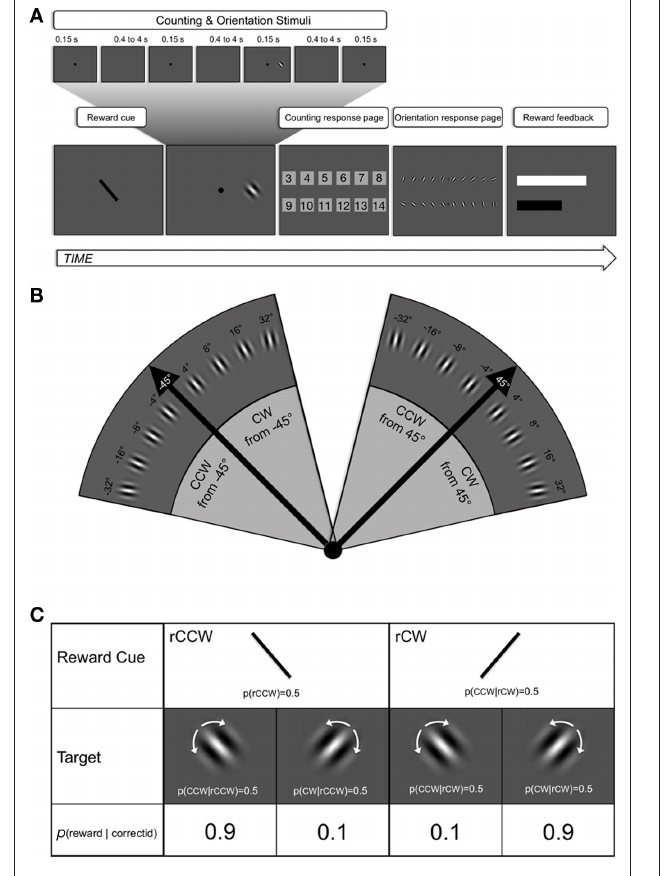
Figure 1 | Temporal structure of a trial (A), stimulus space (B), and reward patterns (C). (A) A trial began with a foveal line (subtending 3 ° of visual angle) displayed for 500 ms and tilted either 45 ° clockwise (CW) or counterclockwise (CCW) from vertical. Then the central attention loading task started. It consisted in a sequence of 3 to 14 flashes (100 ms, random) of a foveal disks with a random inter-disk interval of 0.4–4 s. Subjects were asked to track the exact number of flashes. During one of the flashes (excluding first and last), the target was shown 7 ° to the left or to the right of fixation in synchrony with the corresponding disk. It was tilted CW or CCW relative to either 45 ° or − 45 ° . Then the first response page was displayed; it contained all the digits corresponding to the range of possible disk numbers and subjects had to report to the tracked number of disks with a mouse click. The following display contained the orientation identification and discrimination page. It contained 20 Gabor probes, one for each possible tilt around both the + 45 ° (upper line) and the − 45 ° axis (lower line). The five probes to the left, in each line, corresponded to CW tilts relative to the reference line, while the five to the right corresponded to CCW tilts. Observers had to click on the response probe that best matched the orientation of the peripheral target. After the orientation response, the last page of the trial sequence was shown. It contained a white and a black bar providing feedback about whether or not a trial led to reward, based on a visually salient size increase of the white or the black bar, respectively, and about the amount of rewarded identification needed to achieve another Scratch-and-Win ticket. The white bar was completed, and a ticket donated, after any 20 correct discriminations. (B) “Fan” diagram of the stimulus space. Peripheral targets were oriented Gabor patches whose exact orientation was determined by tilt offset around either a − 45 ° , CCW reference axis (left fan) or a + 45 ° CW reference axis (right fan). The two black arrows in each side represent the two reference axes as well as the two possible cues, one of which was randomly selected and displayed at the beginning of the trial. Notice that (1) the signal was never equal to the axis and, (2) the rightmost item of the left-hand fan is too tilted off-vertical to be confused with the leftmost tilt of the right-hand fan, implying independent coding of the two sets of signals. (C) Different lines of the table indicate, from top to bottom, the probability of each cue type, of each target type given the cue type, and the probability of earning reward given the combination of cues and targets. It has to be clear that: (1) there was an even probability (0.5/0.5) that any of the two cues were shown, (2) there was an even probability (0.5/0.5) that the target was tilted around the − 45 ° or the + 45 ° angle, and this in turn implies that there was no advantage whatsoever in biasing the response toward the cued axis; and finally (3) the probability of earning a reward depended on whether the main axes of cue and target matched or not, according to a 0.9 vs. 0.1 pattern, respectively. Consider that correct counting was the underlying condition for reward, as wrong counting voided the trial, making p (reward) =